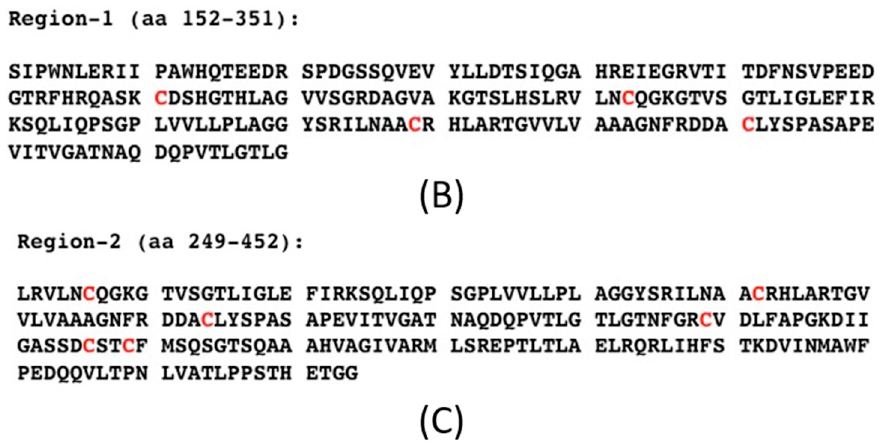
Figure 2 . ( A ) Schematic diagram and amino acid sequences of mouse PCSK9. The full-length PCSK9 is shown (amino acids 1 − 692). The signal peptide (SP) is located at residues 1 − 30, the prodomain is at residues 31 − 151, the catalytic domain is at residues 152 − 452, and the Cys-His rich domain is at residues 453 − 692. The amino acid sequence of the catalytic domains is shown (aa 152–452); all Cysteines (C) are marked in red. ( B ) The amino acid sequence of region-1 of the mPCSK9 (aa 152–251) contains four Cysteines and should yield three different disulfide isomers as predicted. The theoretical molecular weight is 21,201.86 Da. All Cysteines (C) are marked in red. ( C ) The amino acid sequence of region-2 of the mPCSK9 (aa 249–452) contains six Cysteines and should yield fifteen different disulfide isomers as predicted. The theoretical molecular weight is 21,342.56 Da. All Cysteines (C) are marked in red.